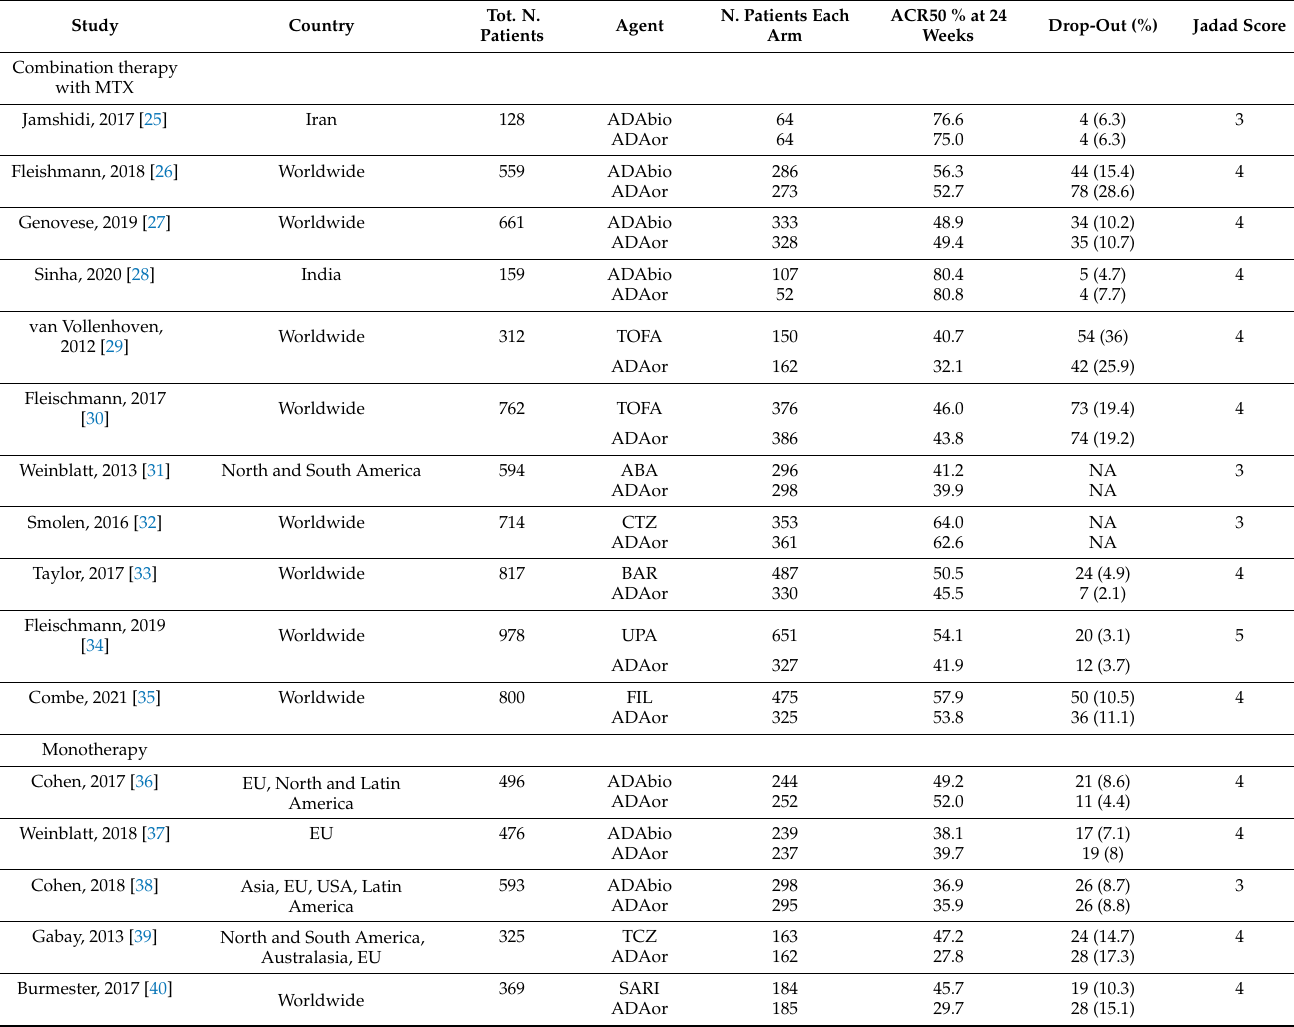
Table 1. Characteristics of individual studies included in the network